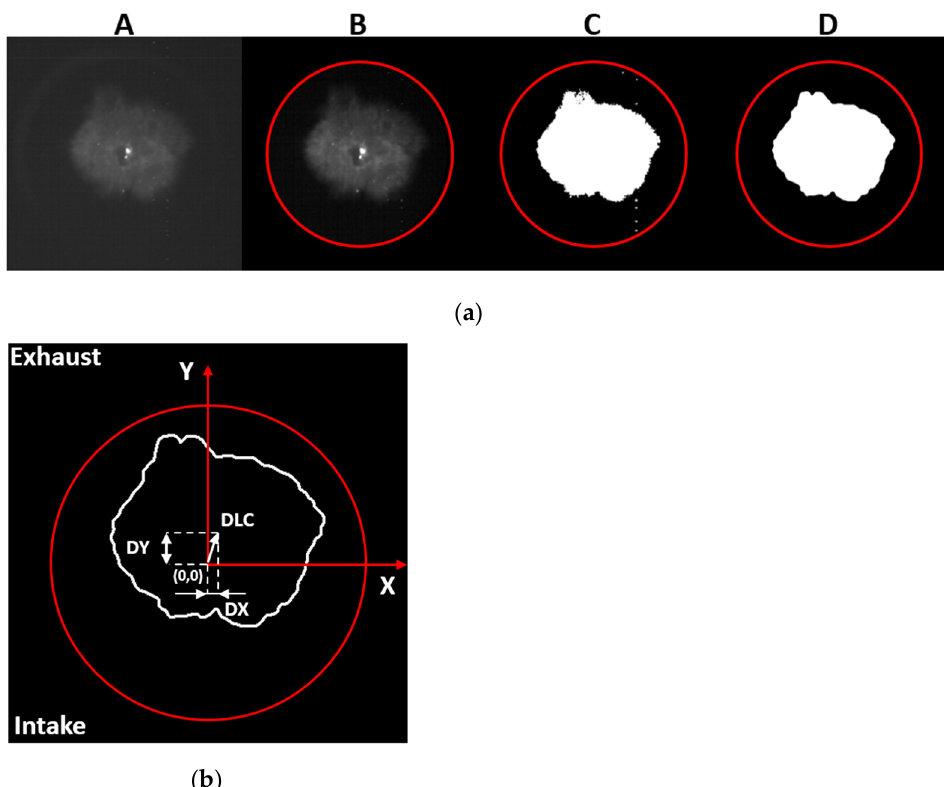
Figure 2. ( a ) Sequence of steps applied for image processing: ( A ) original raw data, ( B ) circular mask and gamma/brightness improvement, ( C ) image binarization, ( D ) FFT correction. ( b ) Flame area morphologic details.